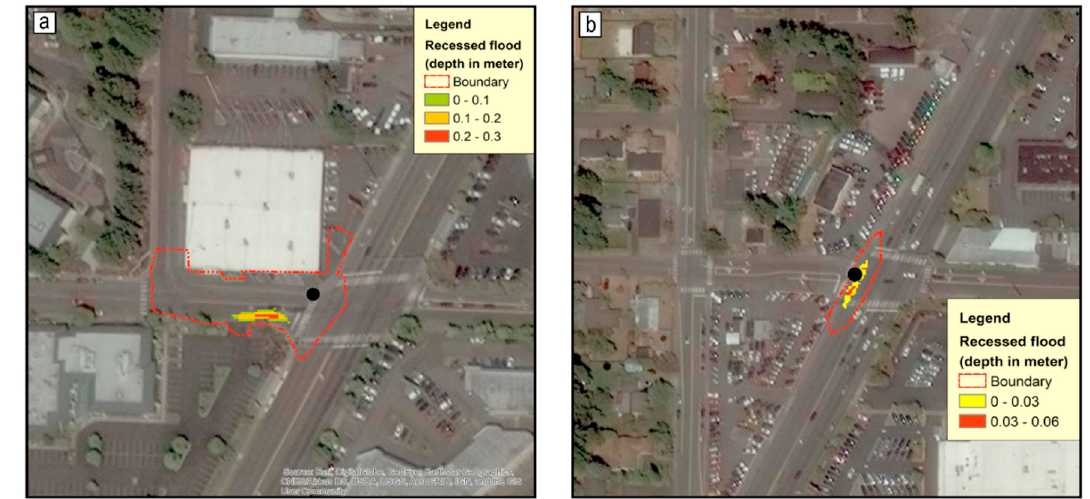
Figure 12. Flood spatial extents aftermath of storm and flood recession into the manholes for Case 1 ( a ) and Case 2 ( b ).